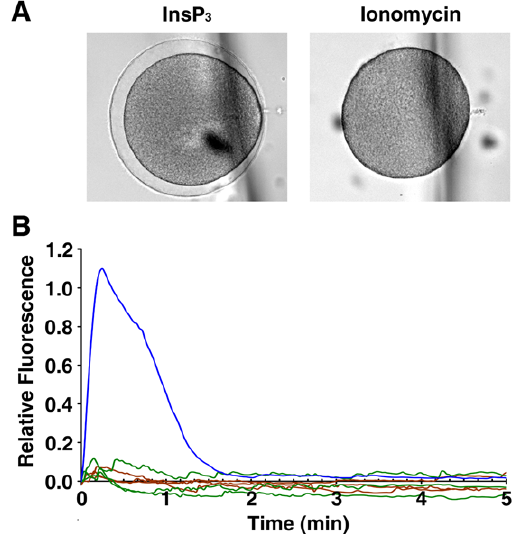
Figure 8. Microinjected ionomycin does not induce Ca 2 + increase inside the starfish eggs. P. miniata oocytes were microinjected with Calcium Green and induced to mature in 10 m M 1- MA for 1 h. Under the CCD camera, the mature eggs were microinjected with InsP 3 (without caging, 5 m M in pipette tip), ionomycin (50 m M), or the injection buffer only. Results of one of the three independent experiments are shown. ( A ) Transmission views of the eggs 10 min after microinjection. ( B ) Quantified Ca 2 + signals for InsP 3 (blue curve), injection buffer (green), and ionomycin (brown).